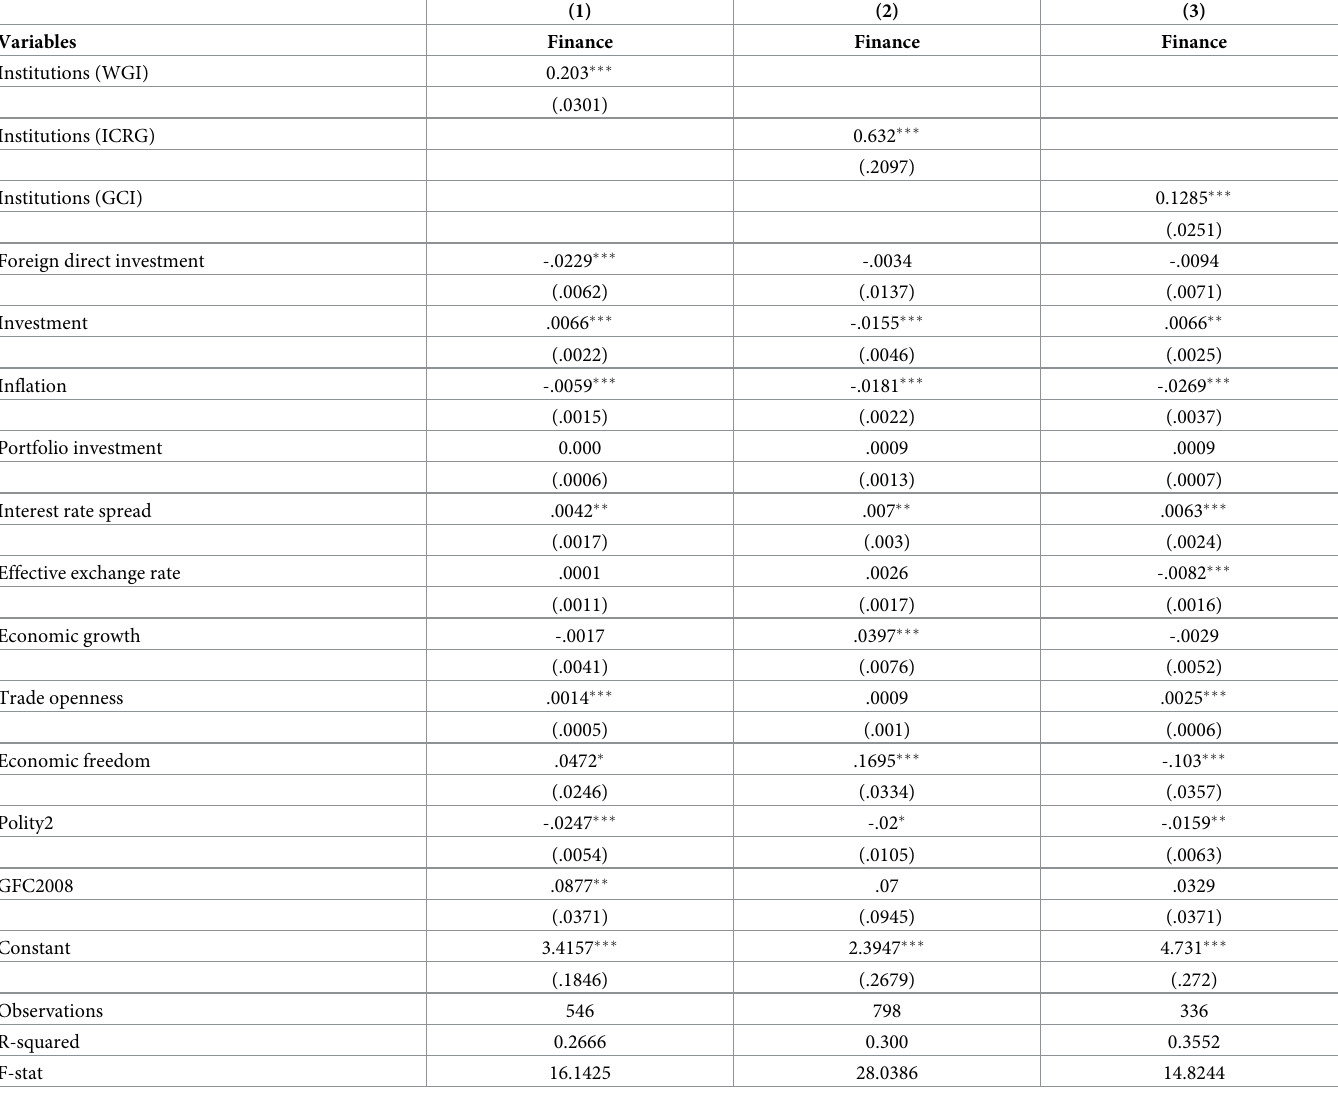
Table 3. Institutions and finance—OLS